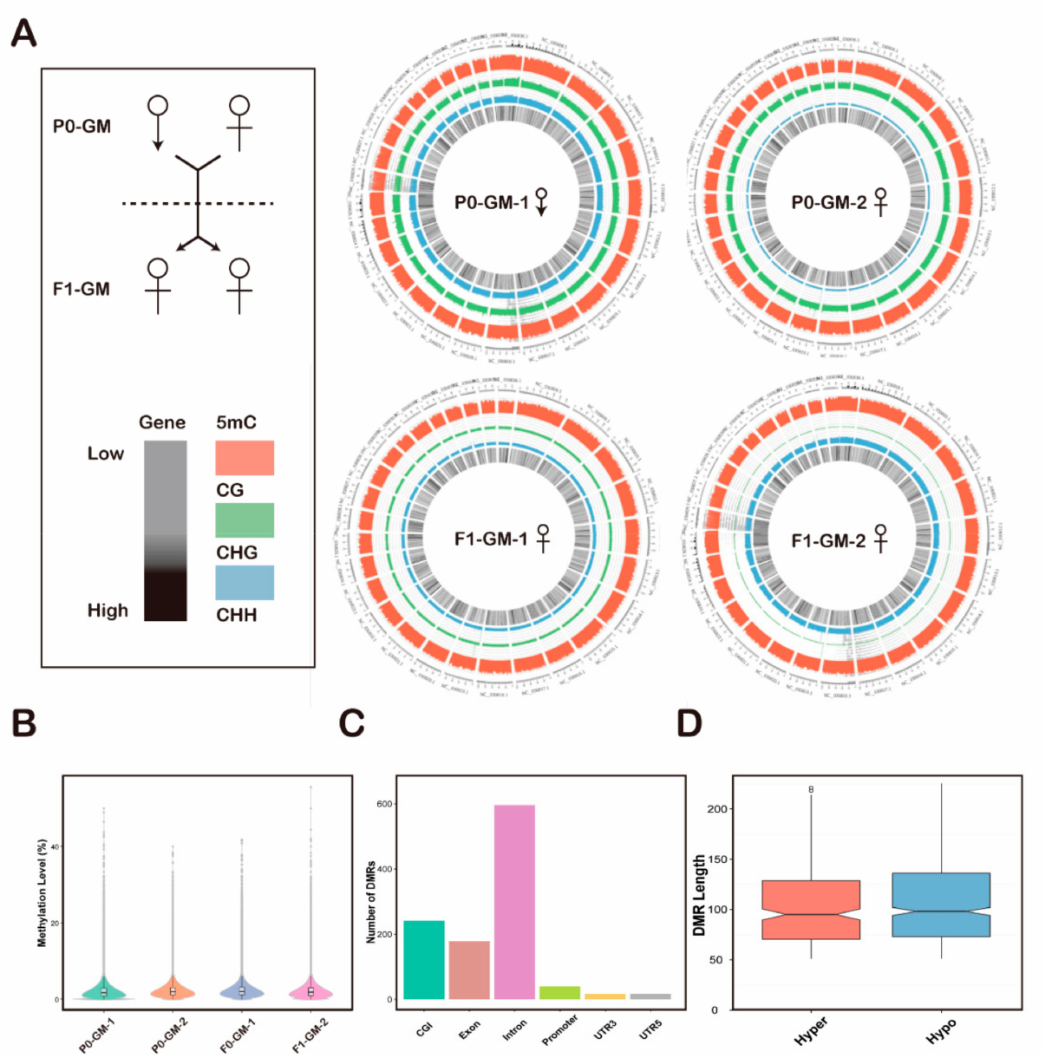
Figure 4. Methylation level profiles for the skin samples of cashmere goats. ( A ) Circus plot showing the genome-wide relationship between the DNA methylation and gene expression of the skin samples. The outermost ring displays the chromosome numbers and bands. The second ring (red) shows the methylation of CHG (H = A, C, or T). The third ring (green) shows the methylation of CG. The fourth ring (blue) shows the methylation of CHH (H = A, C, or T). The inner most circle (black) represents gene expression. 5mC, 5-methylcytosine. P0-GM-1, a male from P0 for an generational methylation study; P0-GM-2, a female from P0 for an generational methylation study; F1-GM-1, the one of twin o ff spring from F1-2-NM for an generational methylation study; F1-GM-2, the another of twin o ff spring from F1-2-NM for an generational methylation study. ( B ) a violin plot showing the methylation levels of the skin samples with 2kb sliding windows. ( C ) Distribution of di ff erentially methylated CpGs and genes of di ff erentially methylated regions (DMRs); CGI, CpG iland. ( D ) Comparison of DMR length distribution between hyper and hypo. Hyper, hypermethylation; Hypo, hypomethylation. Expression data for the P0-GM and F1-GM skin samples from sequencing were used for di ff erential expression analysis. We found 36 highly expressed (‘DE-high’) and 58 lowly expressed (‘DE-low’) genes in F1-GM skin samples (Figure